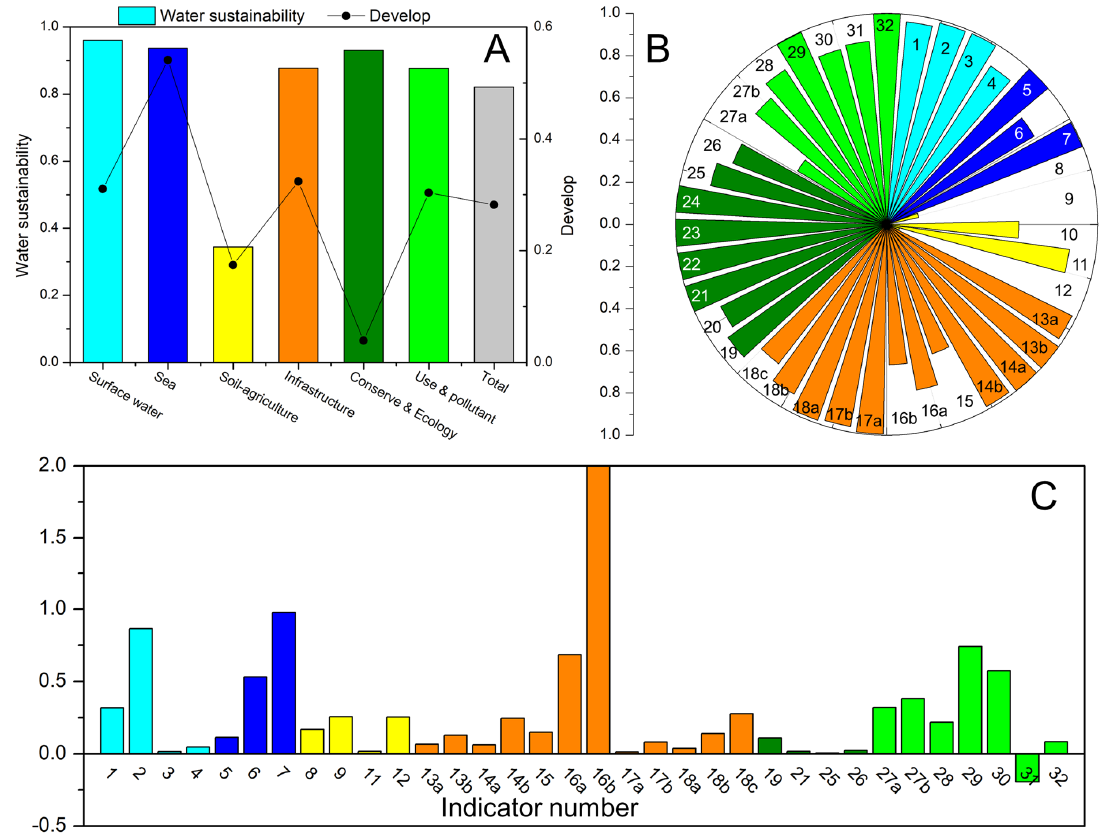
Figure 1. The field −− ( A ) and indicator −− specific ( B ) results of China’s water sustainability evalua- Figure 1. The field—( A ) and indicator—specific ( B ) results of China’s water sustainability evaluation tion and the field −− (A the scatter −− line) and indicator − specific ( C ) development of water sustaina- and the field—(( A ) the scatter—line) and indicator–specific ( C ) development of water sustainability bility between 2015 and 2021 (the number is the same as in Table 1). between 2015 and 2021 (the number is the same as in Table Table 1. The water sustainability evaluation indicator − goal framework.